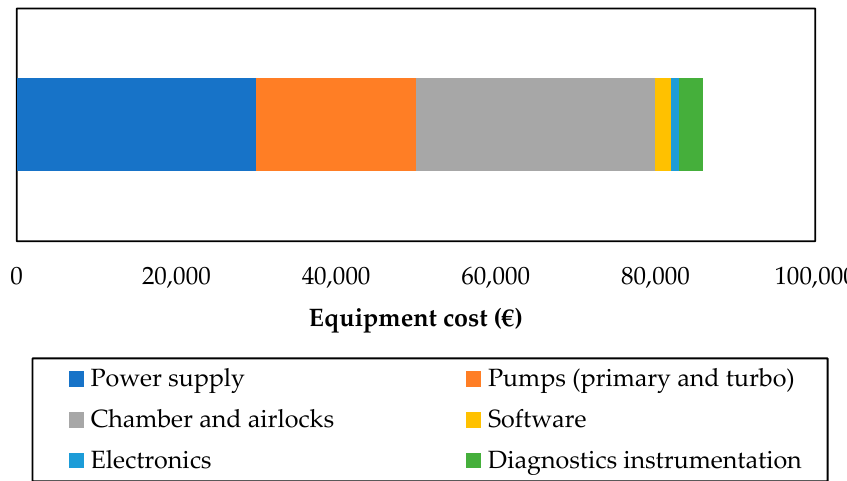
Figure 10. Magnetron sputtering equipment cost breakdown (€).